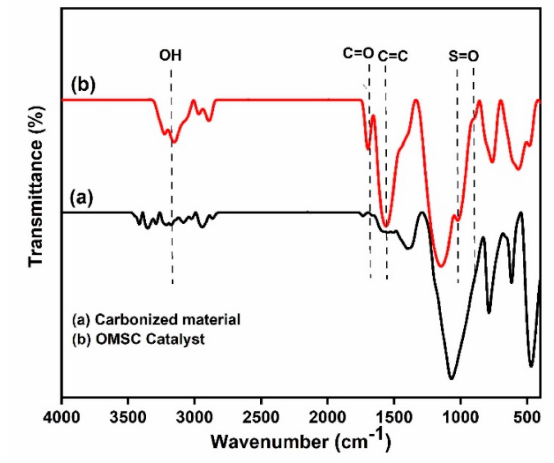
Figure 4. FTIR spectrum of ( a ) the carbonized material and ( b ) OMSC